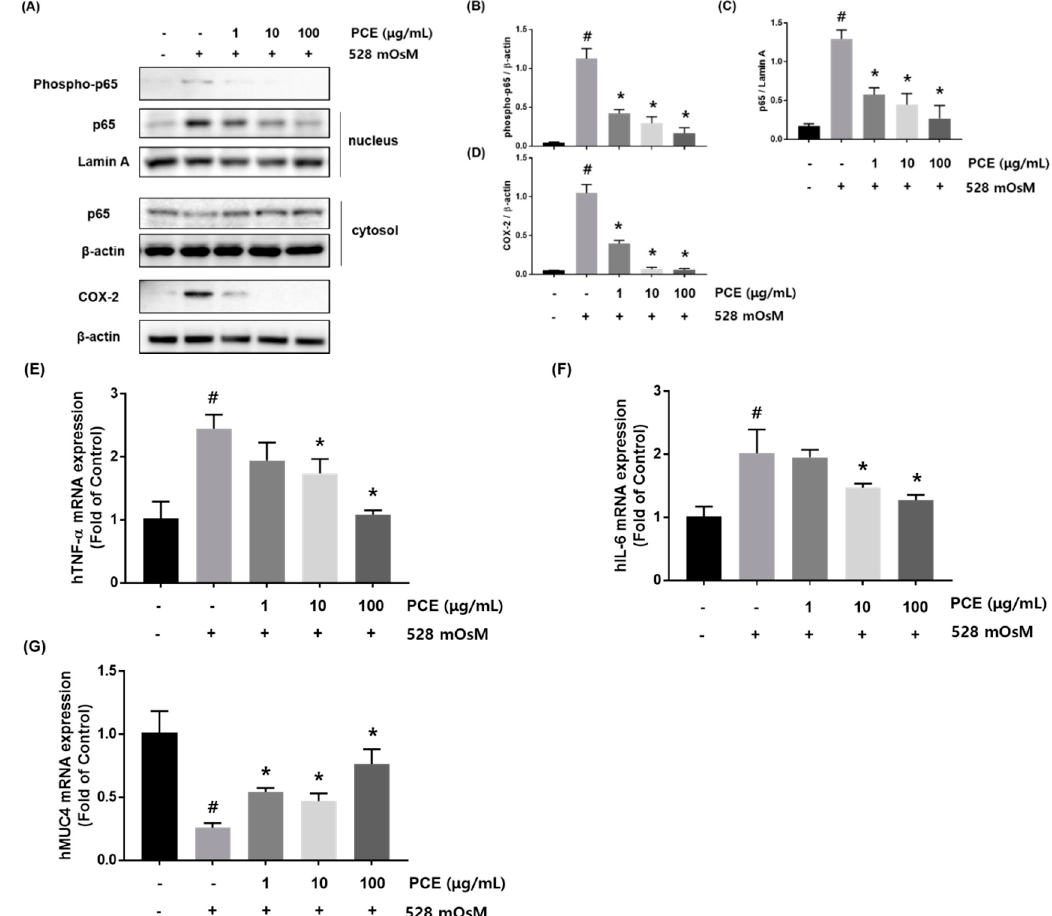
Figure 6. Effects of P. cuspidatum (PCE) on inflammation in hyperosmolar stress-stimulated human corneal epithelial cells (HCECs). ( A ) HCECs were co-treated with the indicated concentrations of PCE and hyperosmotic media (528 mOsM) for 1 h or 8 h. The protein expression of phosphor-p65 and COX-2 (Cyclooxygenase-2) was analyzed by western blot analysis. Cytoplasmic and nuclear levels of NF- κ B p65 were detected by western blotting to analyze the translocation of NF- κ B. β -actin and Lamin A were used as loading controls. ( B – D ) The relative intensities are expressed as the ratio of phosphor-p65, nuclear p65, and COX-2 to β -actin or Lamin A. RNA was extracted from hyperosmolar stress-stimulated HCECs, and the mRNA levels of ( E ) TNF- α , ( F ) IL-6 , and ( G ) MUC4 were assessed by real-time PCR assay. GAPDH was considered an internal control. Data are the mean ± SEM of three independent experiments for all groups. # p < 0.05, significantly different from untreated group, * p < 0.05, significantly different from hyperosmotic-treated group.